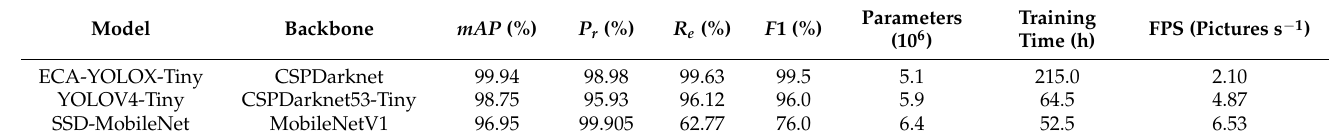
Table 6. The training results of similar network models.